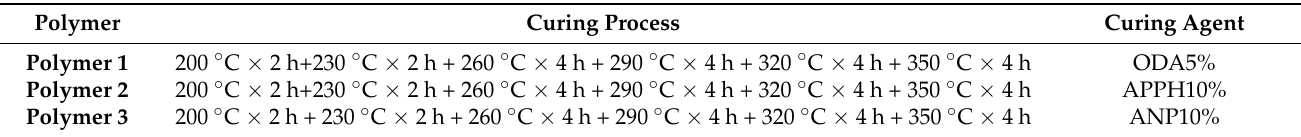
Table 1. Curing process of PN